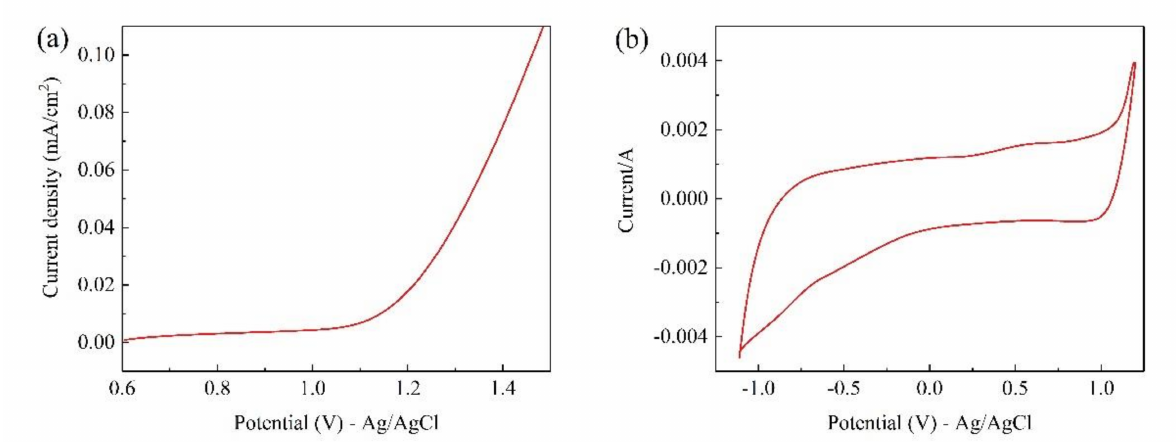
Figure 3. LSV ( a ) and CV ( b ) plots for Ti/Ta 2 O 5 -IrO 2